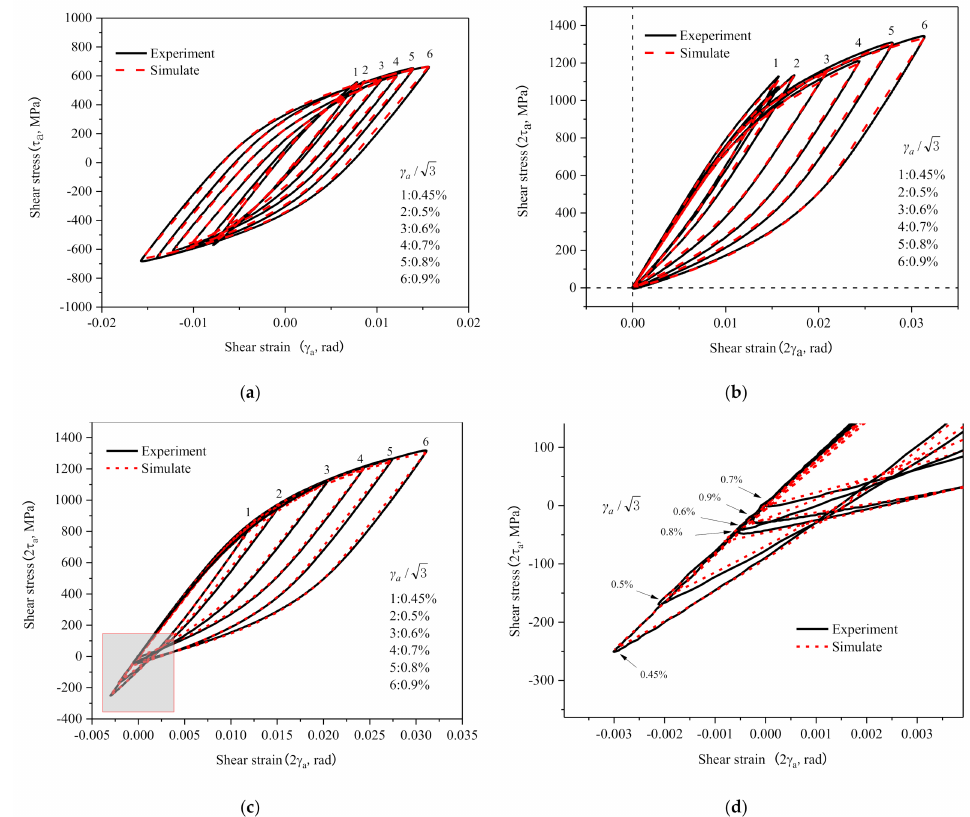
Figure 7. ( a ) The comparison of experiment and simulation of half-life hysteresis loops at different shear strain amplitudes; ( b ) the lowest point of the hysteresis loop overlaps at the origin (0, 0); ( c ) different shear amplitudes are translated along the elastic range; ( d ) locally enlarged view of block diagram in Figure